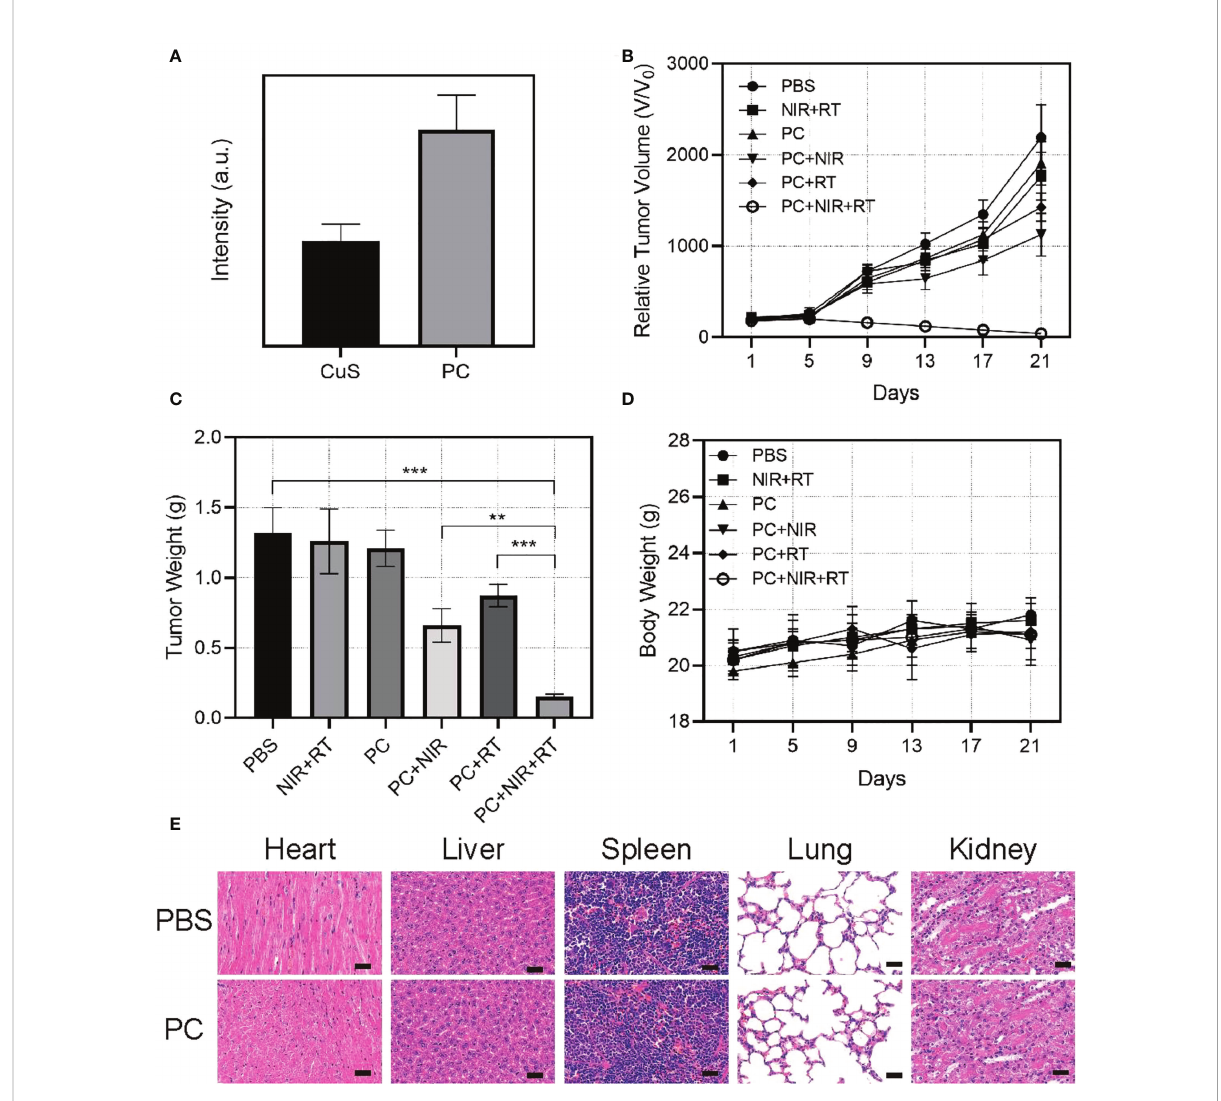
FIGURE 4 Fluorescence intensity of DiL in tumor tissue 24 hours after injection of DiL-labeled nanoparticles (A) . Relative tumor volume change (B) , and tumor weight (C) and body change (D) . Results of H&E-stained images for mice ’ s major organs, including the heart, lung, liver, kidneys, and spleen, after exposure to various therapies 21 days post-injection (E) . Scale bars: 75 µm. **p < 0.01, ***p <